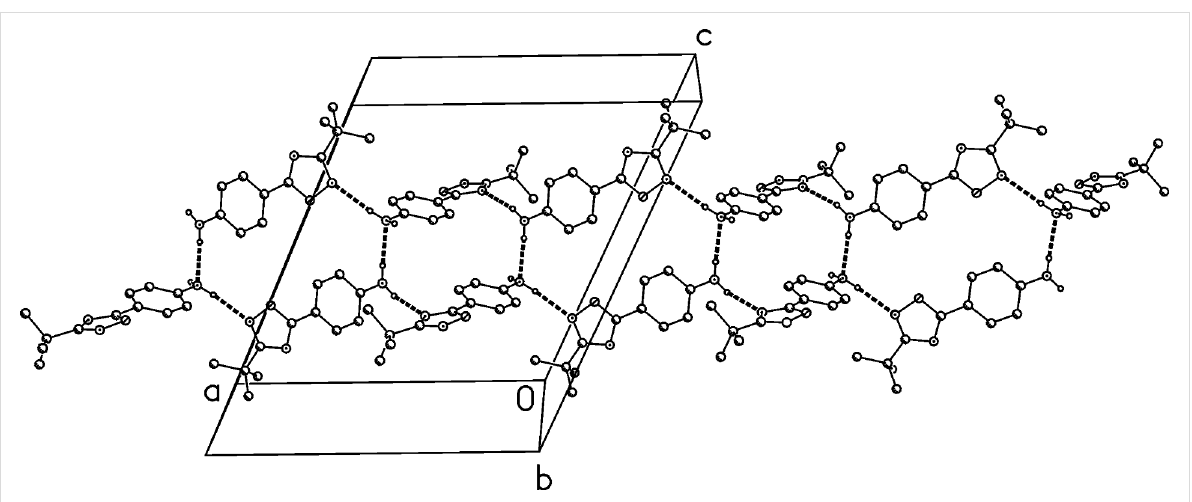
Figure 4: Packing diagram of compound 1 . Hydrogen bonds are indicated as dashed